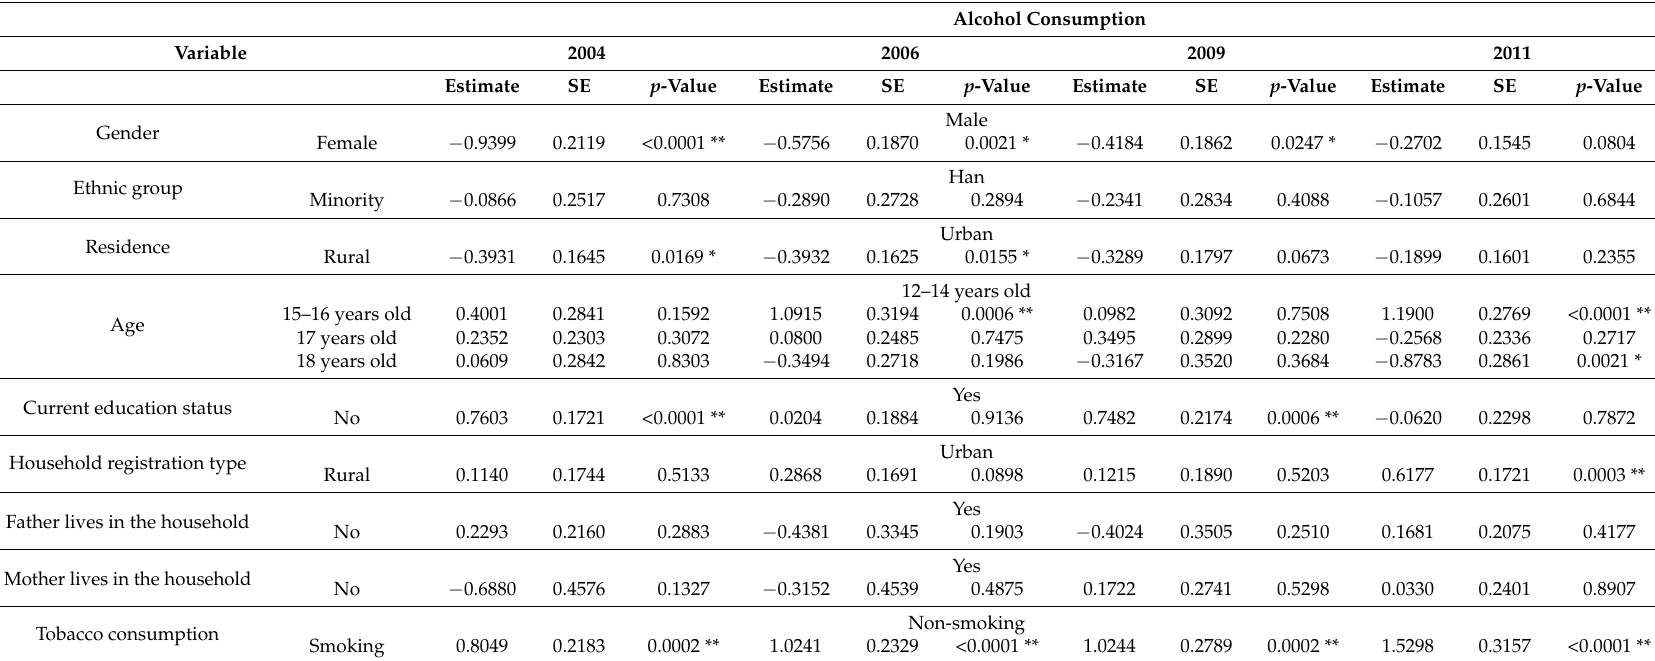
Table 4. Penalized logistic regression analysis for alcohol consumption among Chinese adolescents (from 12–18 years old),